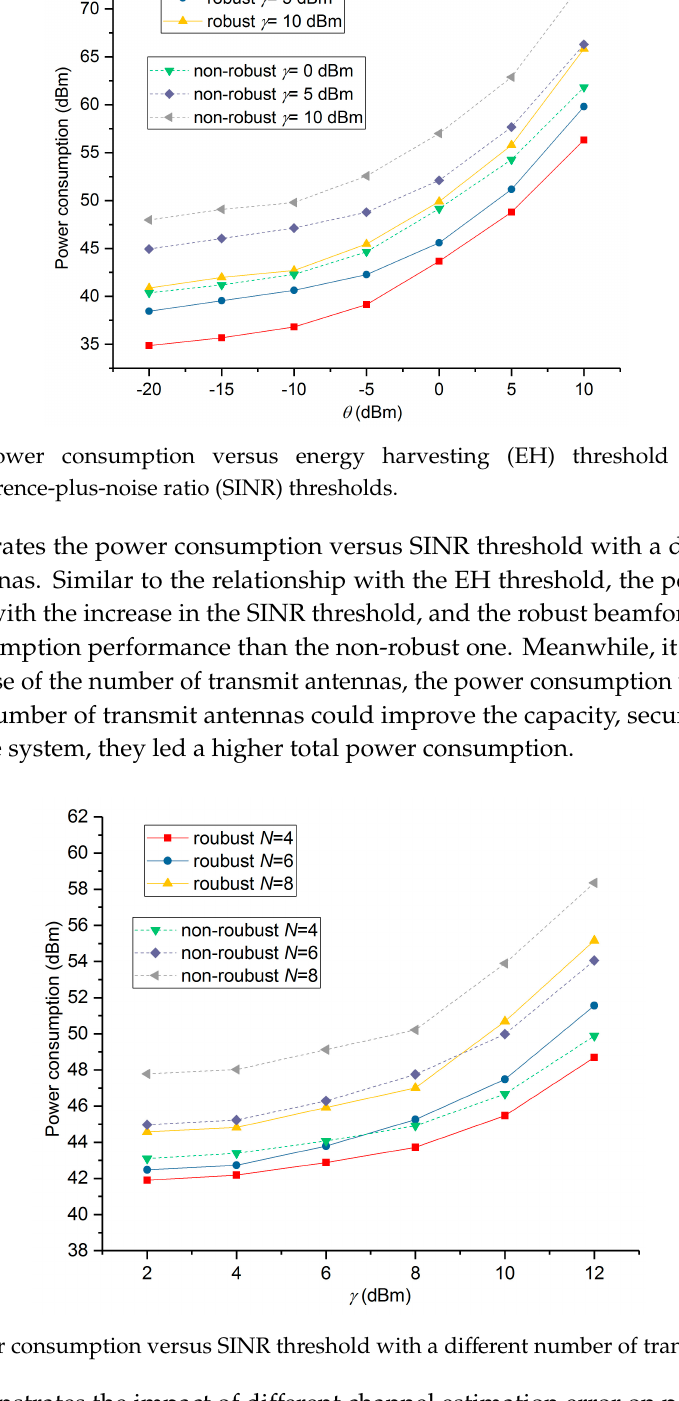
Figure 3. Power consumption versus SINR threshold with a different number of transmit antennas.